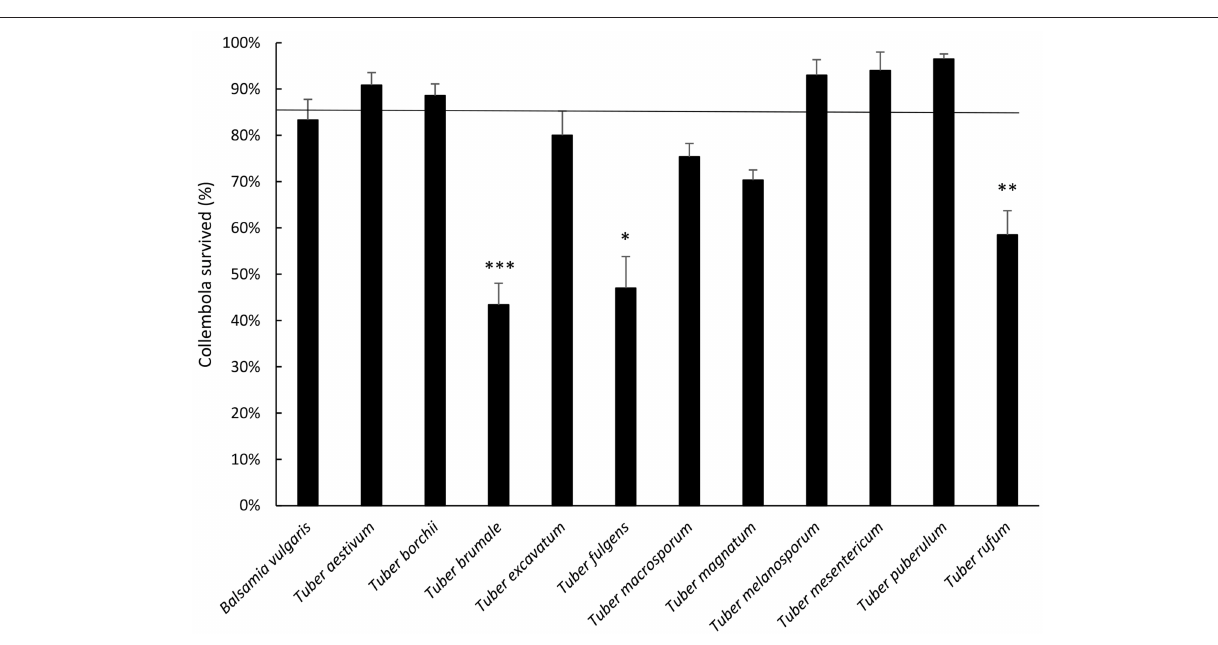
FIGURE 2 | Average percentage ± Standard Error of F. candida surviving adults after 28 days’ feeding on truffles. The horizontal line represents cereal mixture (control). Asterisks correspond to significant differences between truffle and control: * p < 0.05, **0.05 > p > 0.01, *** p < 0.01. For the differences between truffles, see Supplementary Table 1